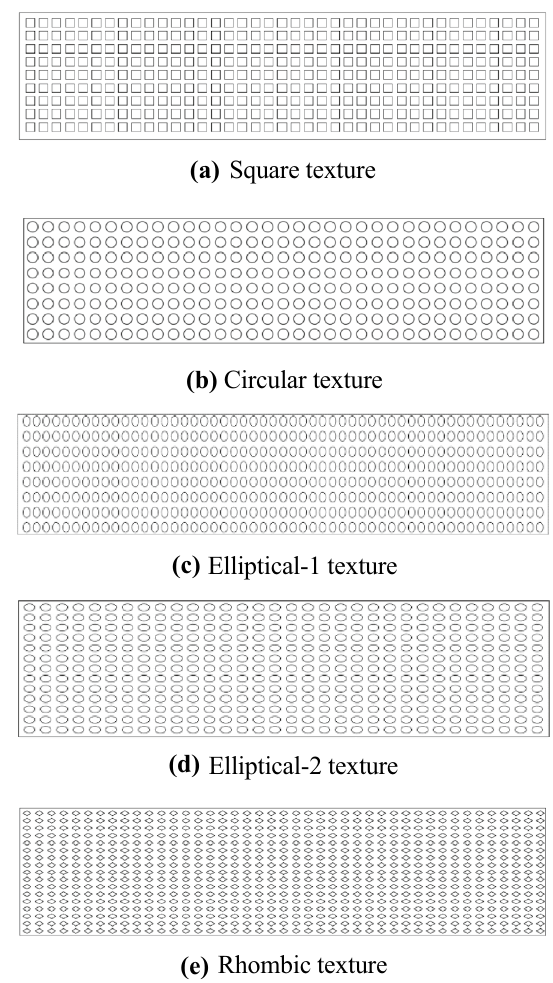
Figure 4 Schematic diagram of the texture of different